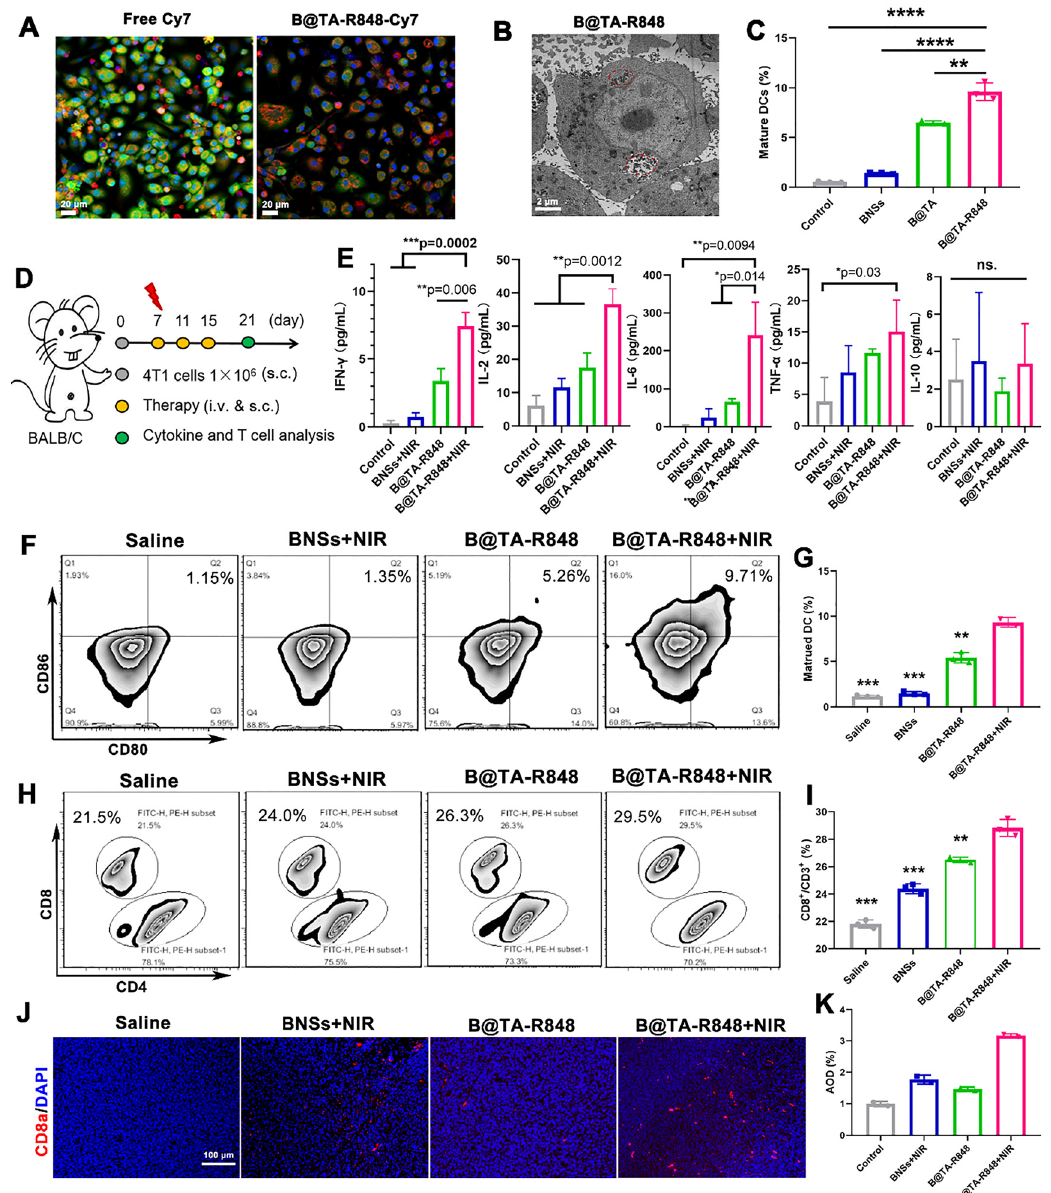
Figure 6: Antitumor immune response achieved by synergistic photo immunotherapy with B@TA-R848. (A) Confocal images of dendritic cell internalization of B@TA-R848-Cy7 (blue: Cell nucleus stained with hoechst33342; green: Cytoplasm stained with FITC; red: B@TA-R848-Cy7), scale bar: 20 μ m. (B) TEM image of dendritic cell internalization of B@TA-R848, scale bar: 2 μ m. (C) Measurement of in vitro BM-DCs maturation (CD80 + , CD86 + ) in total CD11c + dendritic cells with four different treatments (Control, BNSs, B@TA, and B@TA-R848). (D) Experimental procedure and schematic diagram for the cytokine, dendritic cell, and T cell analysis with different treatments (Saline, BNSs + NIR, B@TA-R848, and B@TA-R848 + NIR). (E) Quantitative analysis of Th-1 (IFN- γ , IL-1 2/6, TNF- α ) and Th-2 (IL-10) associated cytokines in serum using ELISA kits. (F, G) Flow cytometry determination of dendritic cells maturation (CD80 + CD86 + gated on CD11c + ) in tumor-draining lymph node. (H, I) CD3 + CD8 + T cells in spleen (CD4-CD8 + gated on CD3 + ). (J, K) Confocal imaging of tumor immuno fl uorescence showing CD8 + T cell in fi ltration (scale bar, 100 μ m). Red fl uorescence represents CD8 + positive T cells (scale bar, 100 μ m).(b,c,d,e,f,g,h) n =3;* p <0.05,** p <0.01,*** p <0.001,**** p <0.0001,andns:notsigni fi cant( p >0.05),analyzedby t -test,followed by Dunnett ’ s multiple comparisons test. Data represent mean ±